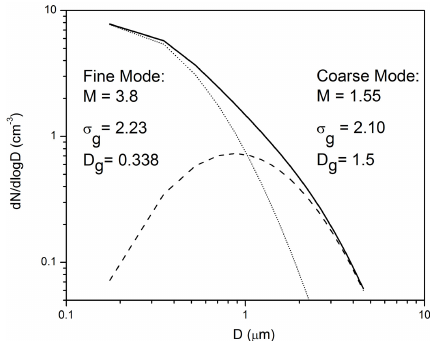
Fig. 16. The agglomerated debris particle shapes of sea salt aerosols.